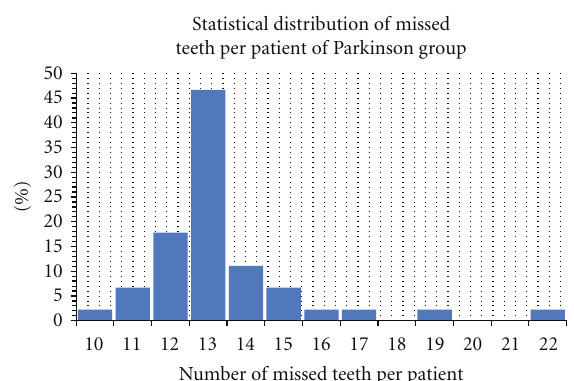
Figure 2: Student’s t -test performed for number of missed teeth on control group patient.